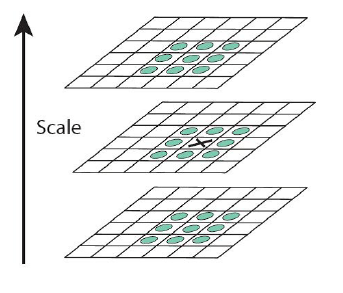
Figure 4. Non-maximal suppression. If it is greater than its 26 neighbors in 3 × 3 regions at the current and adjacent scales, the pixel marked ’X’ is selected as a